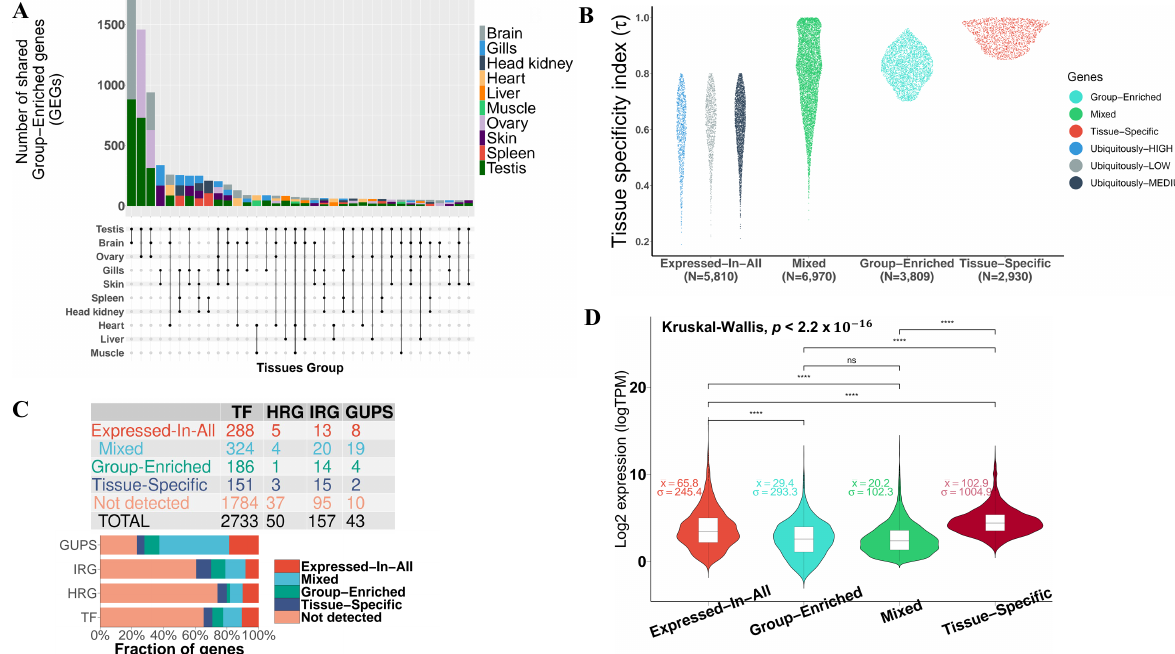
Figure 2. Classification of protein-coding genes detected in pikeperch ( Sander lucioperca ). ( A ), Upset plot depicting different gene sets and the number of shared Group-Enriched genes in each set. ( B ), Sinaplot showing the distribution of the tissue specificity index τ in each genes class. ( C ), Number of transcription factors (TF), hypoxya-related genes (HRG), immune-related genes (IRG), and genes under positive selection (GUPS) in S. lucioperca , found in each category. ( D ), Violin plot showing the distribution of genes expression levels withing each class. Statistical significance ns : Not significant; ****: Extremely significant ( p <